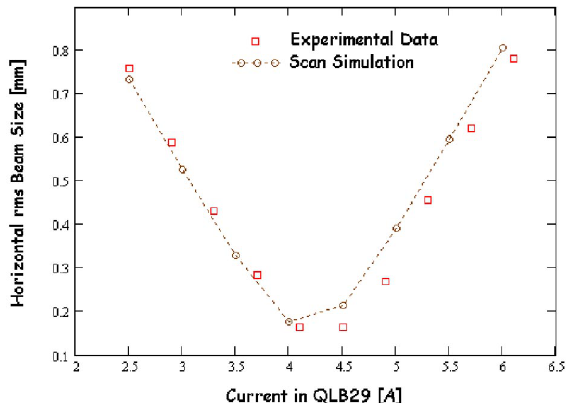
FIG. 11. (Color) Transverse beam size measured by a wire beam scanner as a function of the quadrupole current. The measured data points (squares) are compared to a simulated scan (circles) that is based on the initial Twiss parameters backpropagated from a downstream